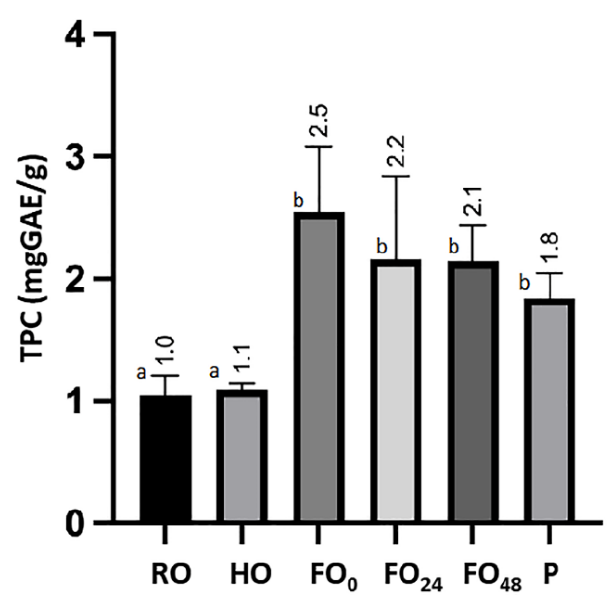
Figure 5. Total phenolic content (TPC) determined in raw (RO), hydrolyzed (HO), fermented oatmeal samples obtained at time 0, and after 24 h, 48 h, and deactivation process (RO, HO, FO 0 , FO 24 , FO 48 , and P) oatmeal samples. Each result is a mean value of a triplicate analysis and error bars indicate the corresponding standard deviations. Values marked with different lowercase letters are significantly different ( p < 0.05), according to Tukey’s test.